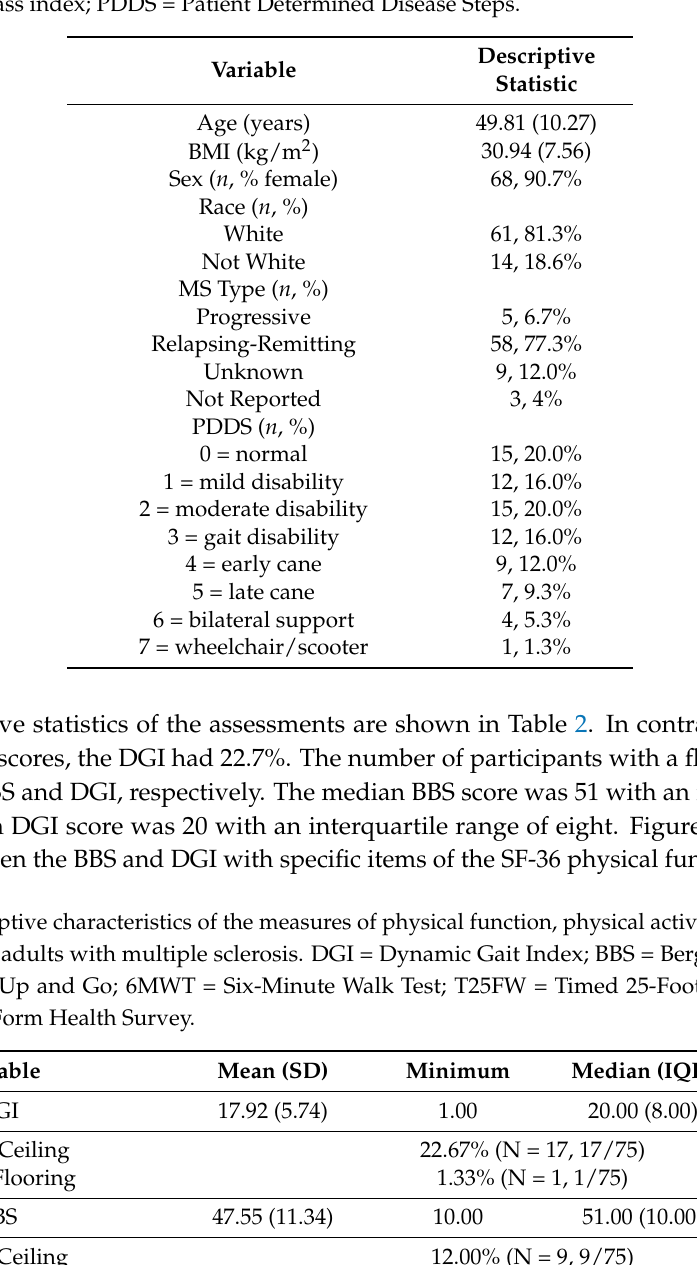
Table 1. Demographic and clinical characteristics of the 75 older adults with multiple sclerosis (MS). BMI = body mass index; PDDS = Patient Determined Disease Steps.